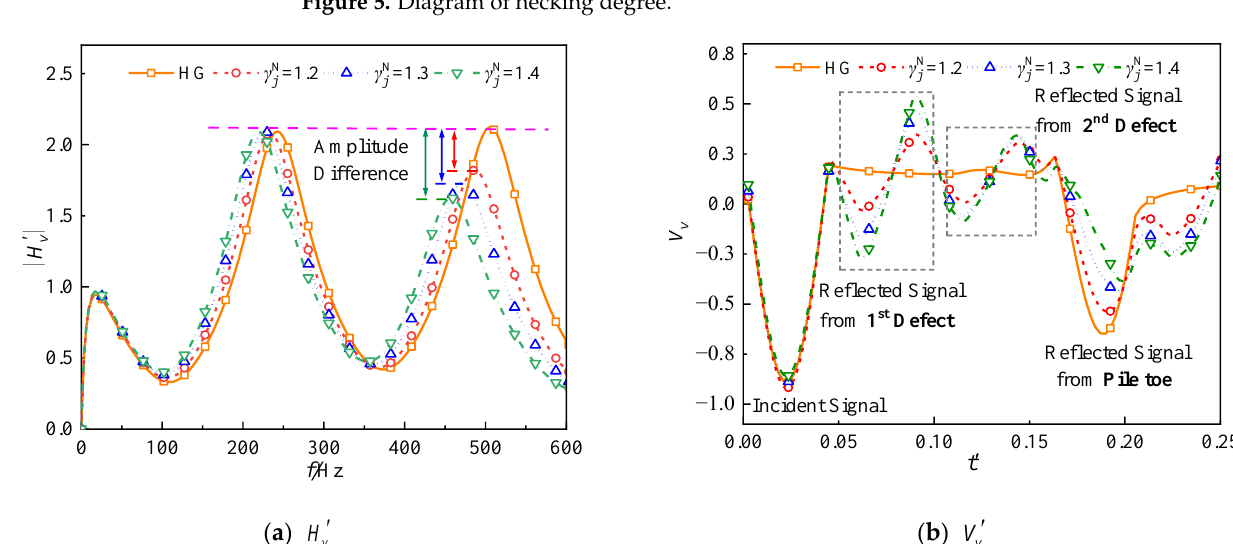
(cid:48) (cid:48) v , ( b ) V v